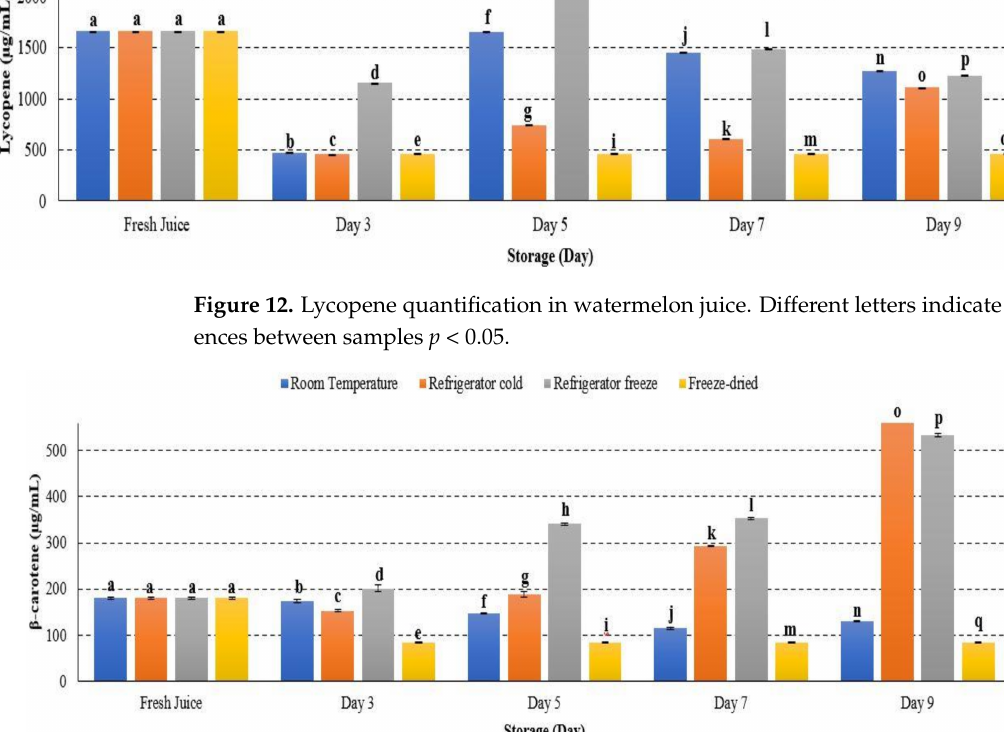
Figure 13. The quantification of β -carotene in watermelon juice. Different letters indicate significant differences between samples p <